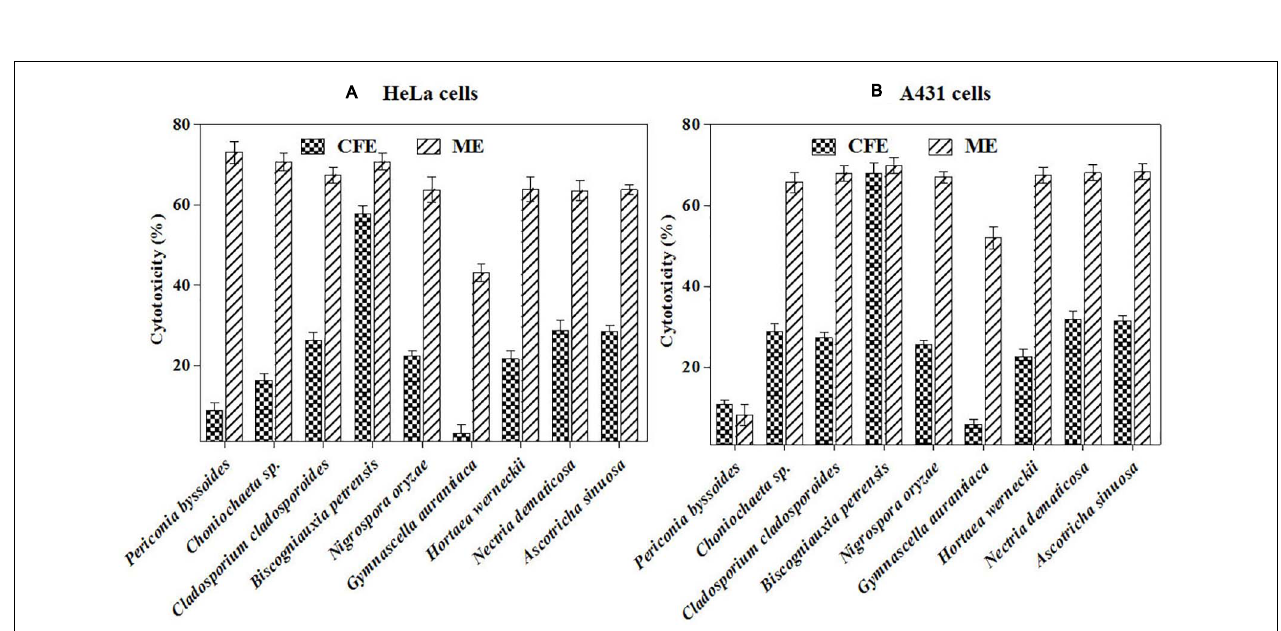
FIGURE 3 | (A,B) In vitro cytotoxicity of selected fungal culture filtrates and mycelia extracts against A431 (A) and HeLa (B) cancer cell line.